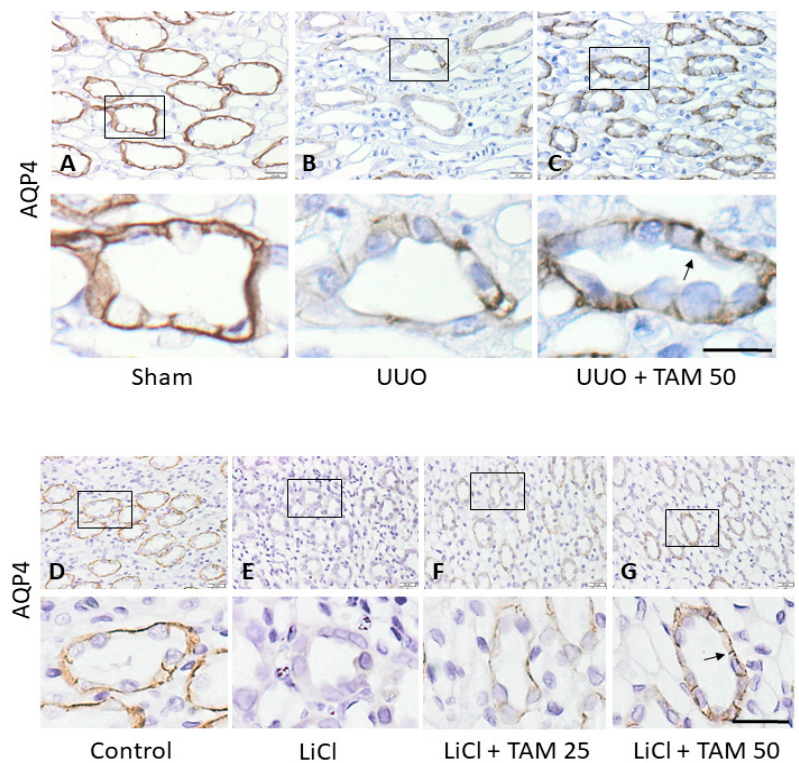
Figure 2. TAM affects expression and localization of AQP4 in rats subjected to UUO and LiCl treatment. ( A – C ): Representative immunohistochemistry images of AQP4 expression in collecting ducts in ( A ) sham rats, ( B ) UUO rats, and ( C ) UUO rats treated with TAM 50 mg/kg. Below shows the insert (n = 3–4 per group). ( D – G ) Representative immunohistochemistry images of AQP4